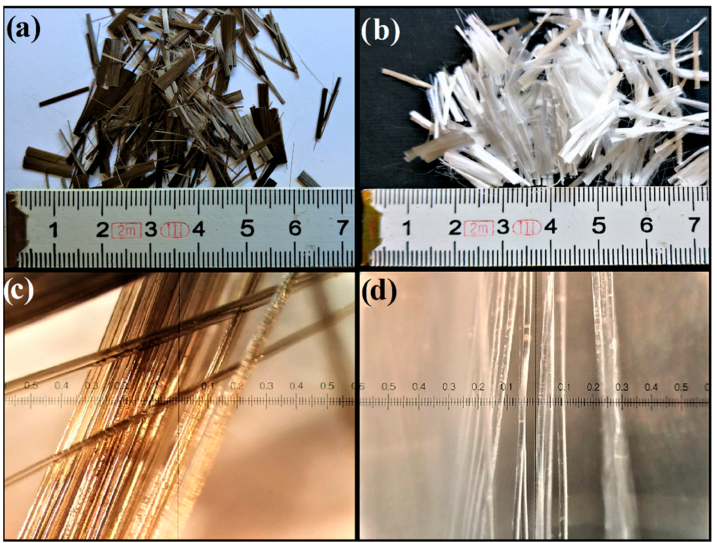
Figure 2. Basalt and polypropylene fibres: ( a ) basalt fibres on a real scale (cm), ( b ) polypropylene fibres on a real scale (cm), ( c ) basalt fibres magnified (0.1 × mm), ( d ) polypropylene fibres magnified (0.1 ×